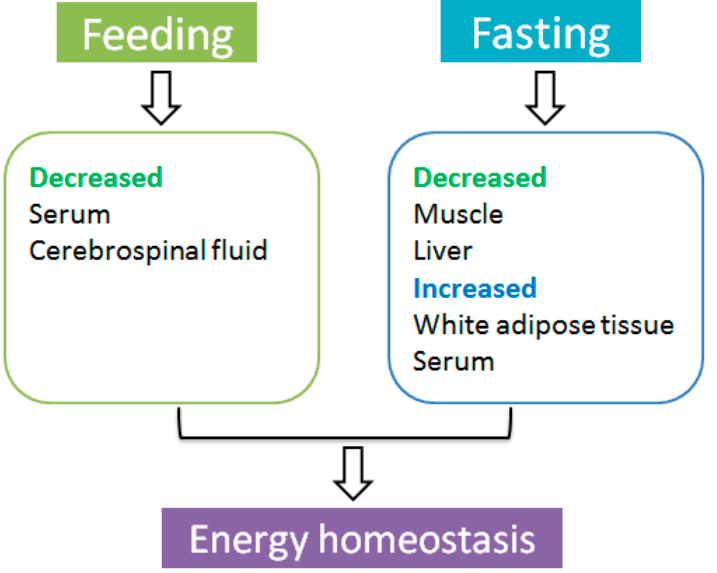
Figure 2. The effect of feeding and fasting on adiponectin expression.